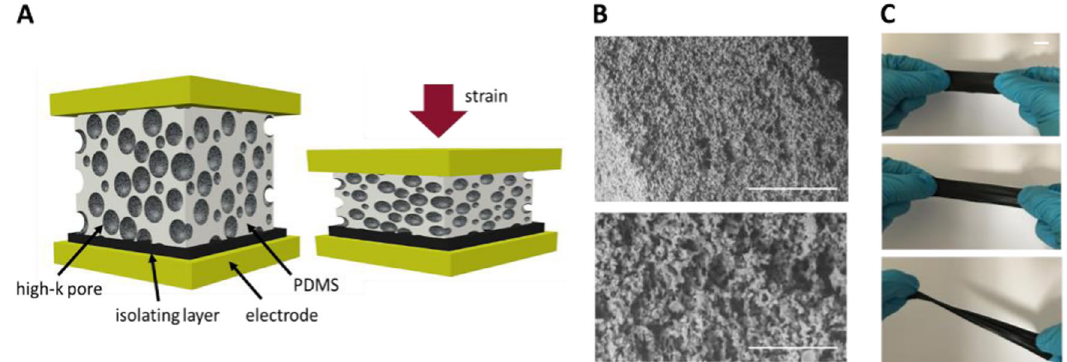
Fig. 1 a Schematic view of polymeric foam fi lled with conductive pores. b Slice views of the internal structure of the CB/PDMS porous material (SEM, scanning electronic microscope), scale bars: top, 300 μ m and bottom, 100 μ m. c From top to bottom: CB/PDMS porous material at rest, stretched and twisted, scale bar, 1